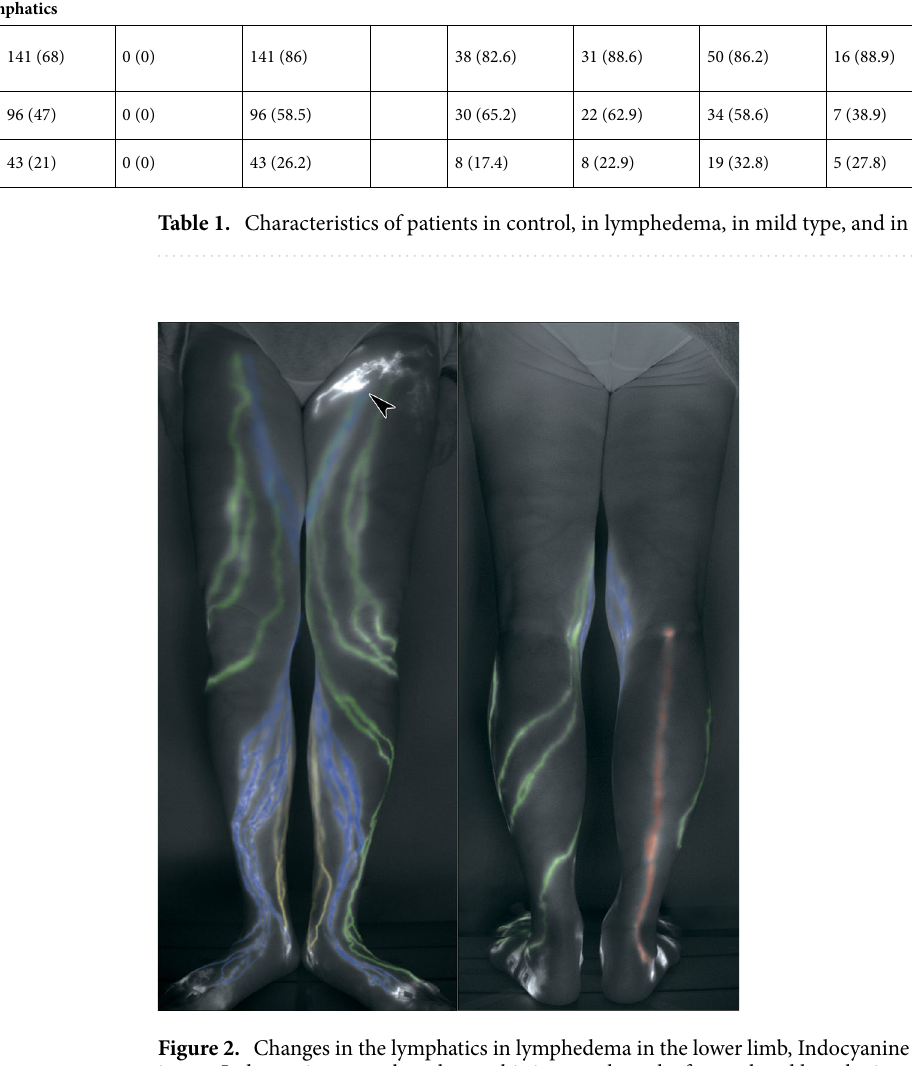
Figure 2. Changes in the lymphatics in lymphedema in the lower limb, Indocyanine green lymphographic image. Indocyanine green lymphographic images show the four-colored lymphatic vessels and dermal back- flow (arrowhead): anteromedial (blue), anterolateral (green), posteromedial (yellow), and posterolateral (red). An image comprised two aspects: anterior (right), and posterior sides (left). The image of the right leg showing four lymphatic groups and no dermal back-flow (DB). Left leg with mild lymphedema showing single defects of posterolateral group, in addition to inguinal DB